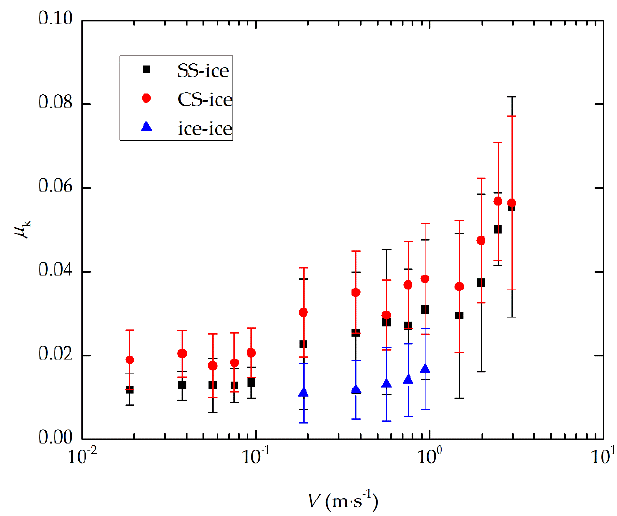
Figure 10. Variations of μ k with velocity V for SS-ice, CS-ice, and ice-ice contacts. The data at a given velocity were the mean values over different test conditions, and the error bars represent the standard deviation.